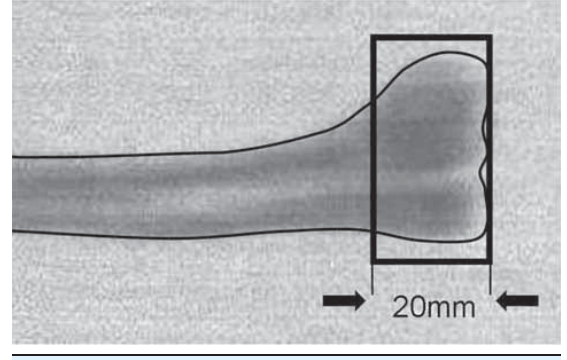
Figure 1. The region of interest (ROI) measured 20 mm from the proximal tip of tibia and included the entire surface area within that region.